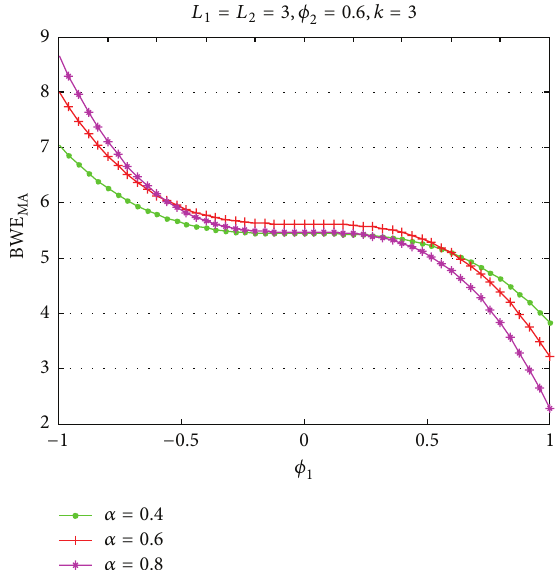
Figure 3: Impact of 𝛼 on bullwhip effect for different 𝐿 1 under the MMSE.